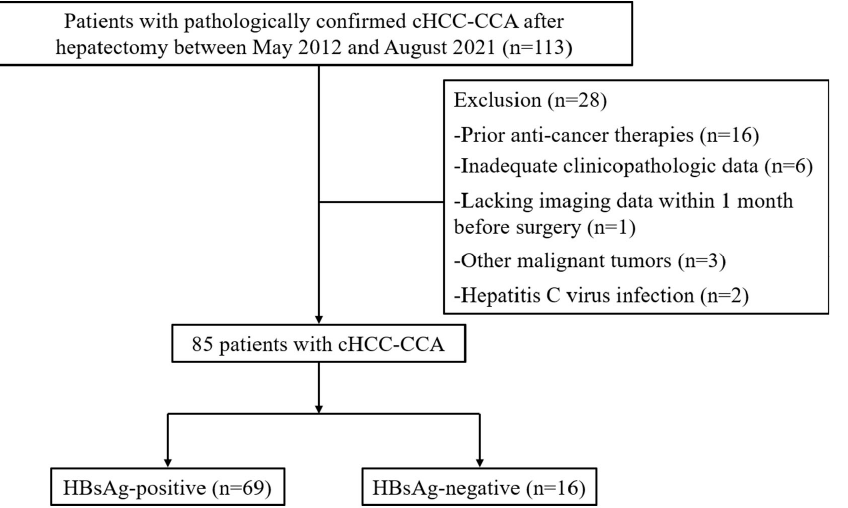
Figure 1. Flowchart of the patient selection process. cHCC-CCA, combined hepatocellular carcinoma and cholangiocarcinoma; MVI, microvascular invasion; HBsAg, Hepatitis B surface antigen.